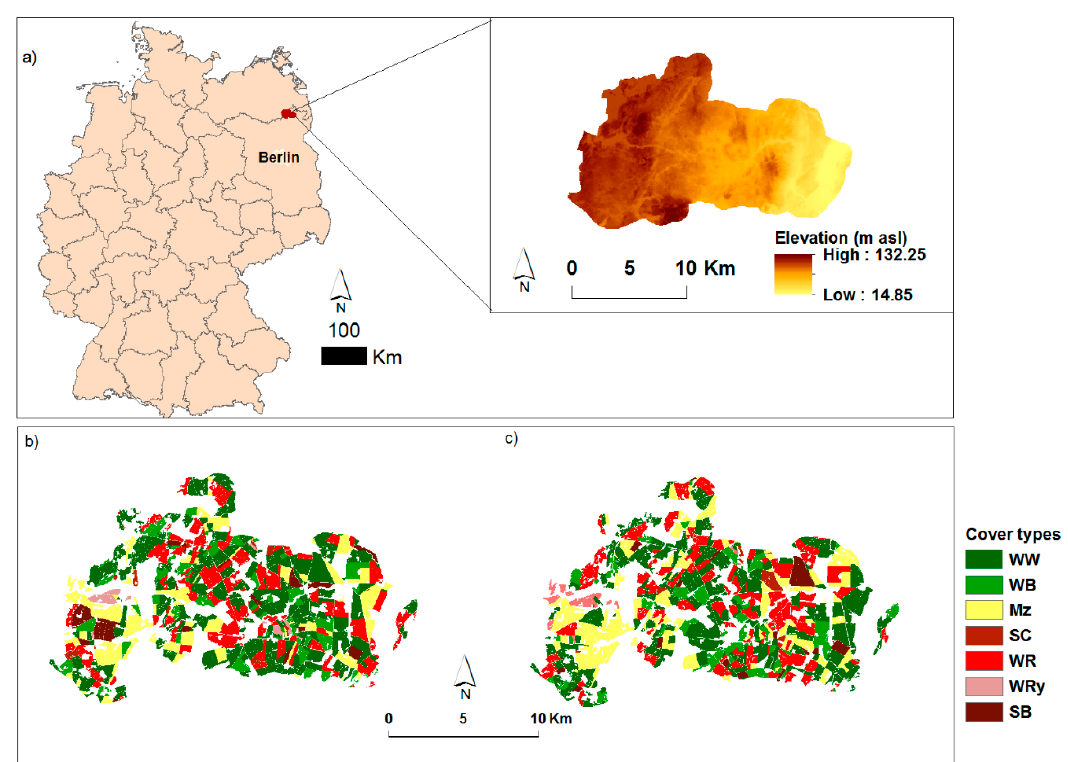
Figure 1. ( a ) Overview and elevation of the study area (Source country border: http://www.diva-gis.org/gdata); ( b ) and ( c ) IACS data representing the agricultural land use of the study area in the year 2015 and 2016 (masked out are forests, grasslands, and built up areas). WW, winter wheat; WB, winter barley; Mz, maize; SC, Summer cereals; WR, winter rape; WRy, winter rye; SB, sugar beets.